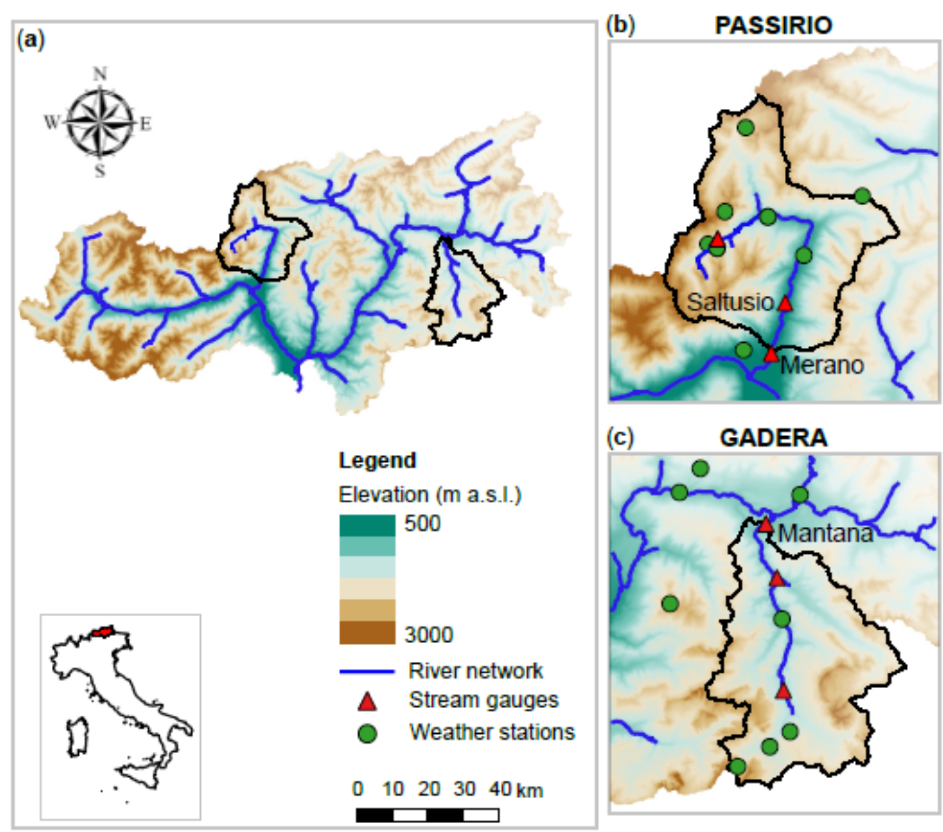
Figure 1. ( a ) Location of the two study catchments within the upper Adige River Basin. The inlet at the bottom left shows the location of the upper Adige River Basin in Italy; ( b ) Passirio catchment; and ( c ) Gadera catchment.